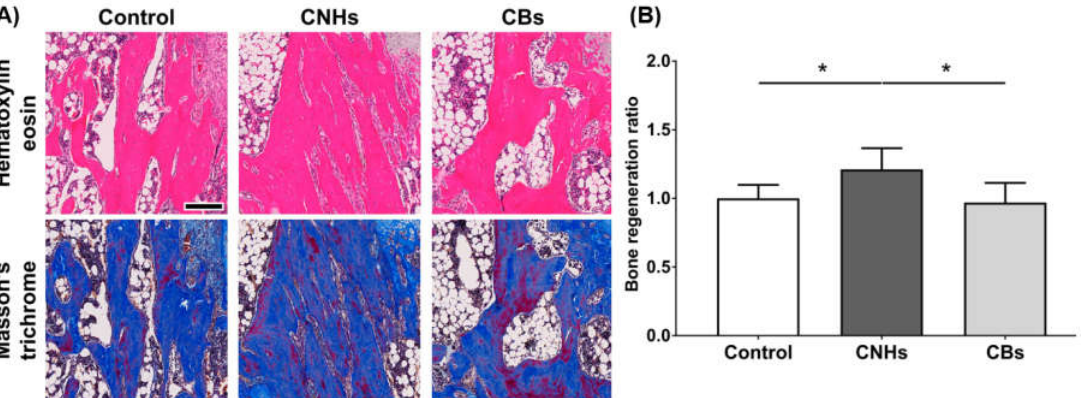
Figure 9 . Effect of CNMs on bone regeneration. ( A ) Scale bar: 200 µm. The sections of tibial specimens of rats exposed to CNHs and CBs were stained with hematoxylin eosin and Masson’s trichrome staining. ( B ) Quantification of bone regeneration. New bone formation in bone tunnels was quantified using Masson’s trichrome staining images in ( A ). n = 6. Statistical significance was evaluated using the Tukey–Kramer test. * p <